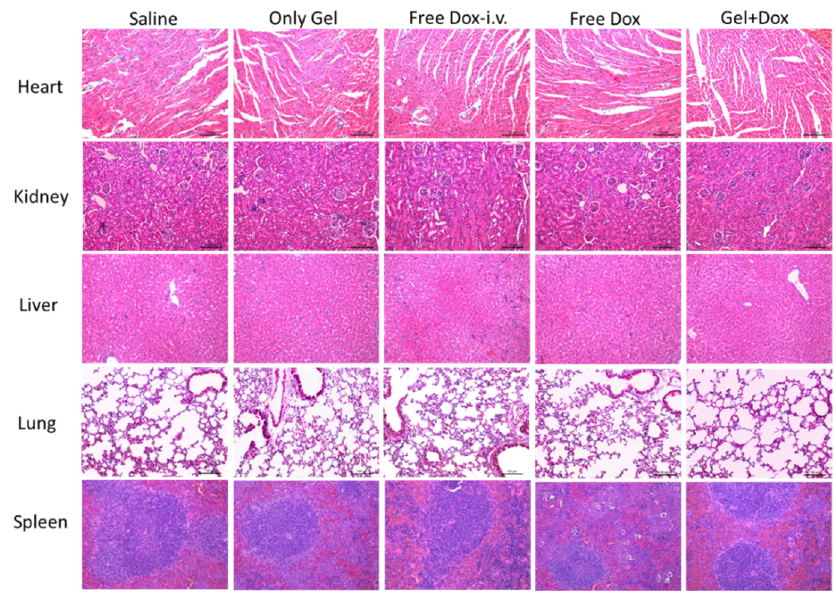
Figure 7. Histological H&E staining analyses of the organs of mice after different treatments. Nuclei were stained blue, and extracellular matrix and cytoplasm were stained red.